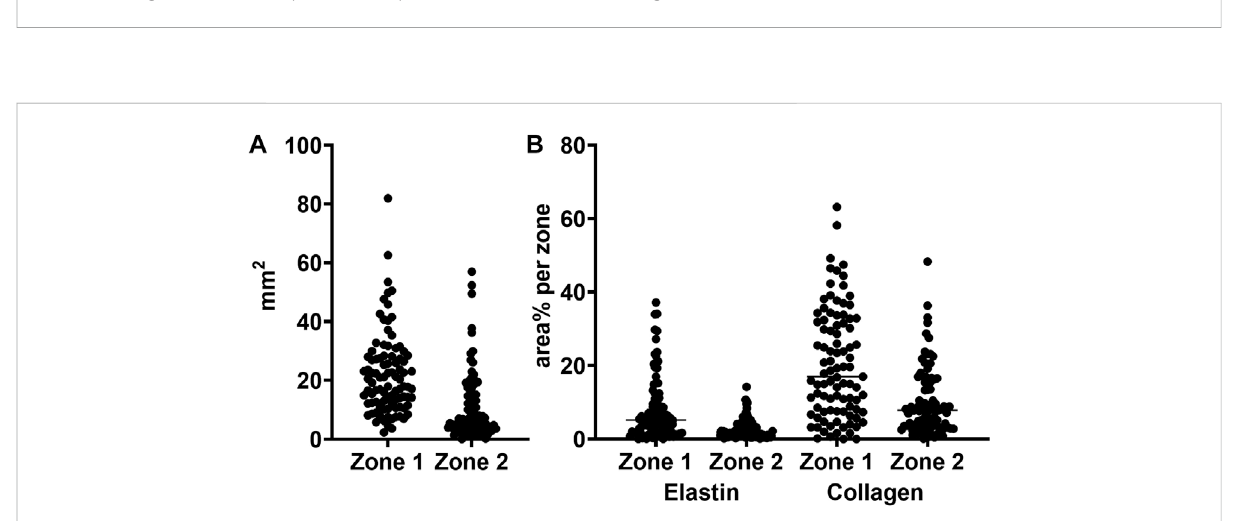
FIGURE 7 Confusion matrix of the performance of the network model on the validation dataset. The numbers denote the fraction of pixels classi fi ed as label x and belonging to label y. The matrix is normalized by true label, i.e., each row summates to 1. The diagonal elements represent true positives, while off-diagonal elements represent false positives (columns) and false negatives (rows).